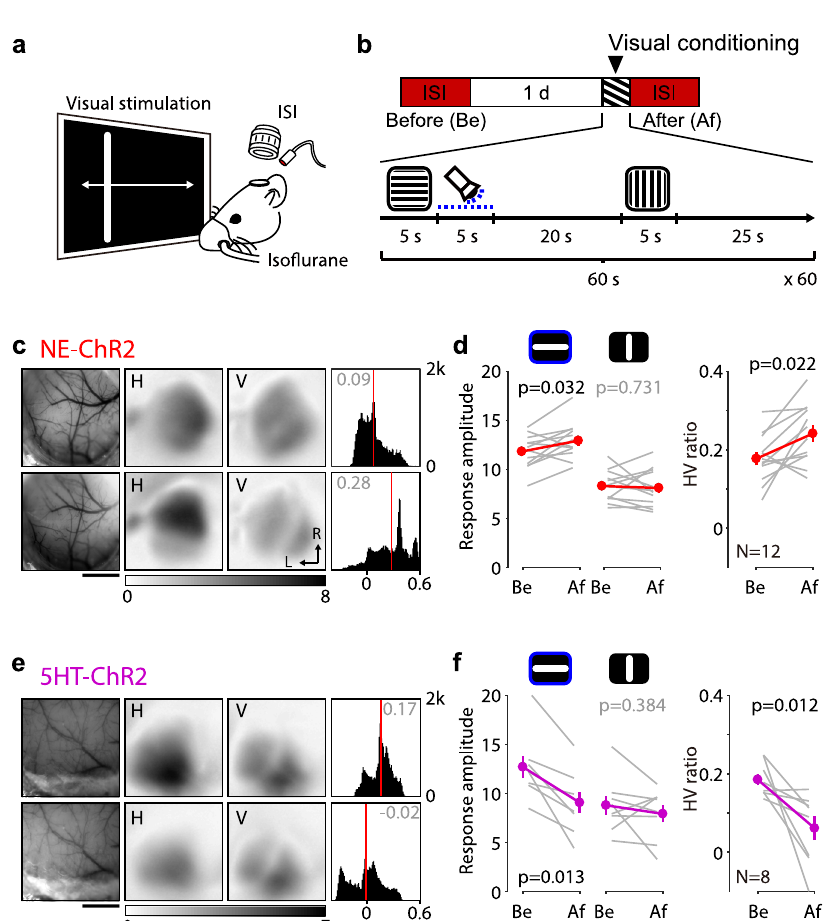
Fig. 1 Potentiation and depression of visual cortical responses by the retroactive action of norepinephrine and serotonin. a Schematic of the optical imaging of the intrinsic signal (ISI) of the visual cortical response from the V1. b Experiment timeline (top) and the visual conditioning protocol (bottom). Blue dotted line indicates photoactivation of ChR2. c , d Optogenetic transformation of LTP trace induces potentiation of the associated visual cortical response of the NE-ChR2 mice. c Representative change of the visual cortical response by the visual conditioning. Left: vasculature pattern of the imaged region used for alignment. Scale bar, 1 mm. Middle: magnitude map of the visual cortical response evoked by horizontal [H] or vertical [V] drifting bar. Gray scale (bottom): response magnitude as the fractional change in re fl ection x10 4 . Arrows: L lateral, R rostral. Right: histogram of HV ratio illustrated in the number of pixels (x-axis: HV ratio, y-axis: number of pixels). d Summary of changes in response amplitude evoked by the horizontal (left) or vertical (middle) drifting bar as well as the change of HV ratio (right) before (Be) and after (Af) the conditioning. Thin line: individual experiments; thick line and symbols: average ± s.e.m. e , f Optogenetic transformation of LTD trace induces depression of the associated visual cortical response of the 5HT-ChR2. Same format with (c and d). Source data are provided as a Source Data fi